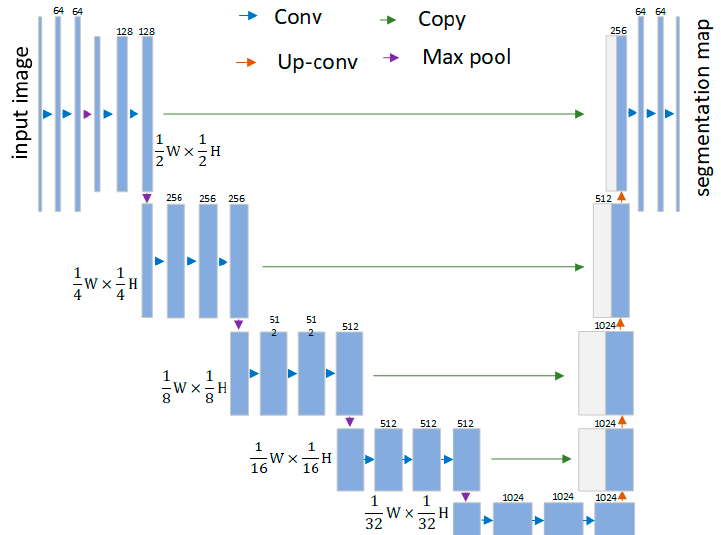
Figure 2. Segmentation network.